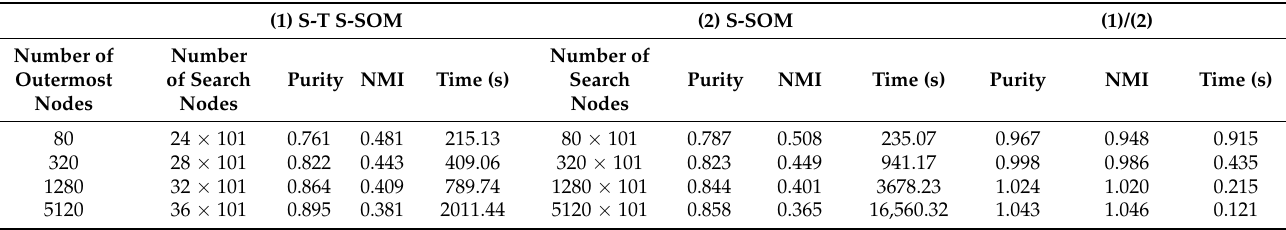
Table 1. Performance of the S-TS-SOM and